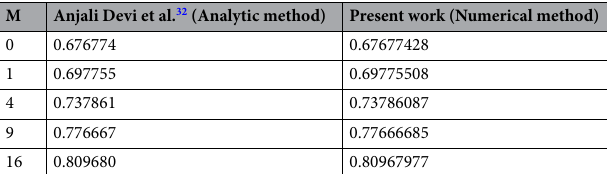
Table 2. h (0) Comparison ( (cid:31) = 1.5, Rp = 100, Sc = 0.62, ϕ = 0, γ = 0).